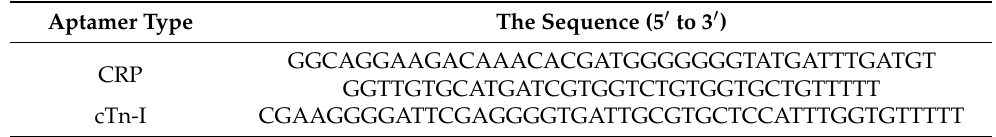
Table 1. The list of the DNA aptamers for different inflammation